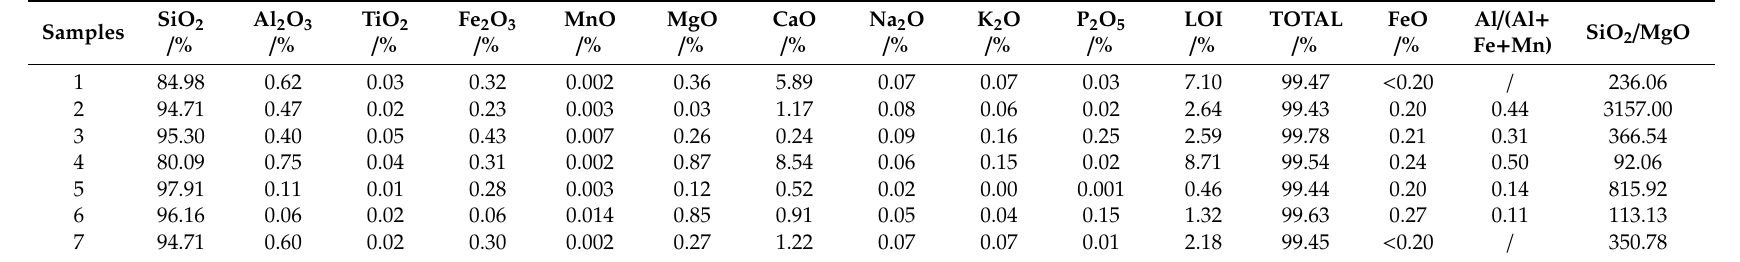
Table 1. Geochemical parameters of dolomite samples in the study